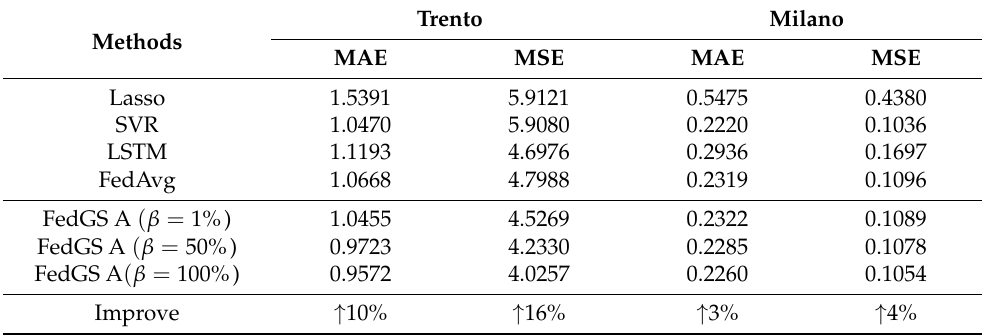
Table 1. Comparison of MSE and MAE prediction performance of different methods on two